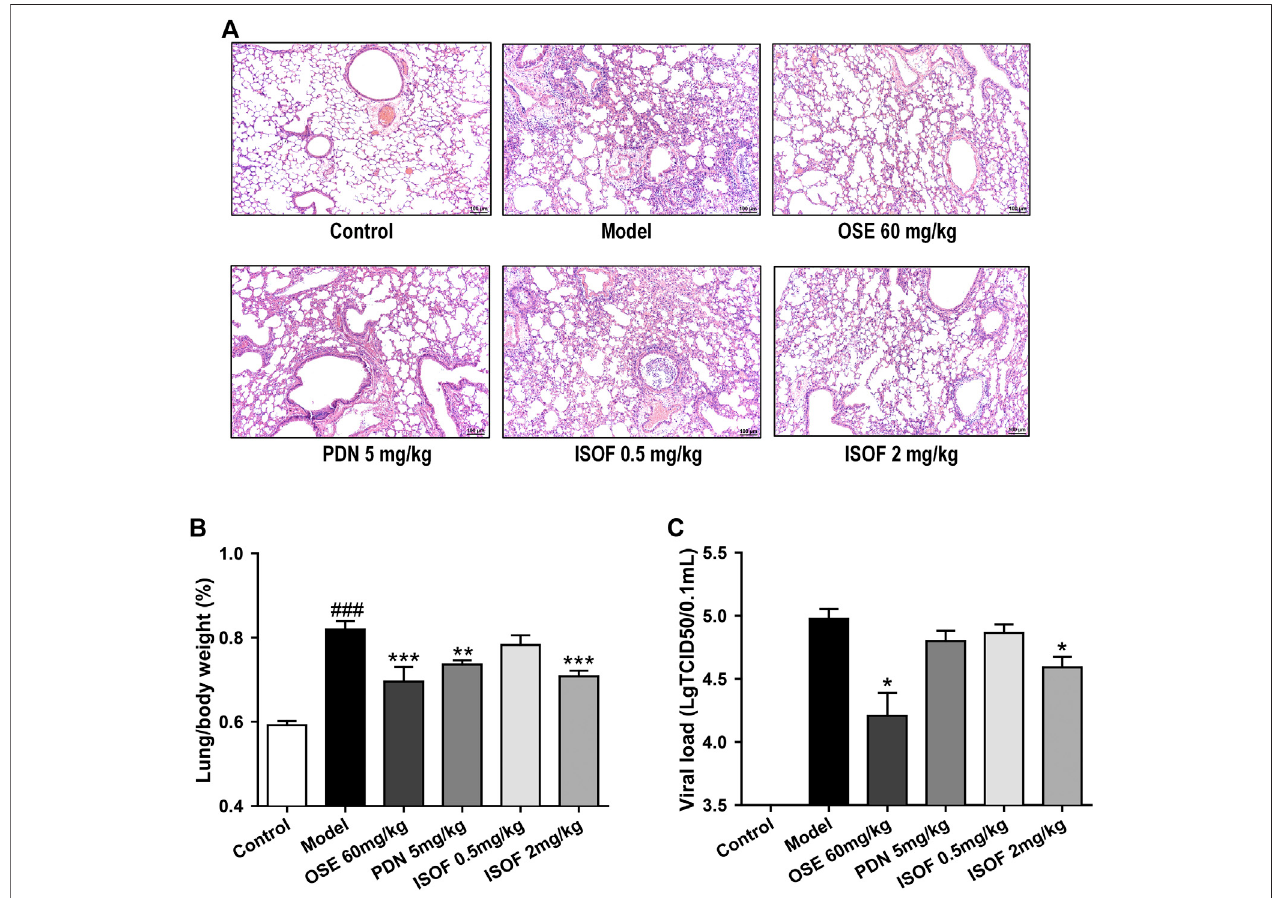
FIGURE 4 | ISOF ameliorated pathological damage of lung tissue in AECOPD model mice. (A) Pathological changes in paraf fi n sections of lung tissue were measured by hematoxylin and eosin (H&E) staining (original magni fi cation: 100 × ). Scale bar (cid:1) 100 μ m. (B) Lung/body weight ratio in each group ( n (cid:1) 12). (C) Pulmonary viral loadineach group( n (cid:1) 6). Dataarerepresentativeimages orexpressed asmeans ± SEM. ### p < 0.001 vs.controlgroup;* p < 0.05,** p < 0.01,and *** p < 0.001vs. model